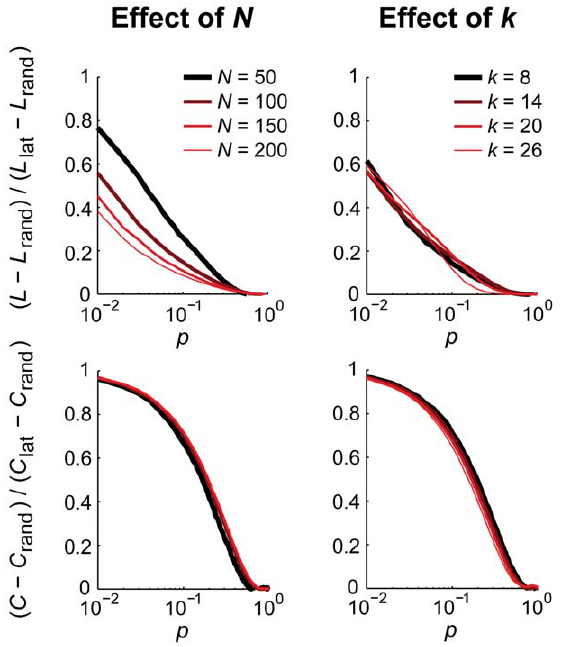
Figure 5. Normalization of graph measures by the range of possible values. Expressing path length ( L ) and clustering coefficient ( C ) as a ratio of the range of obtainable values (lattice - random) diminishes the sensitivity to changes in number of nodes N and average degree k . Only the path length remains largely sensitive to changes in N for a large range of rewiring probabilities p (the four curves do not coincide here). Shown are small-world networks with either a fixed k =10 or a fixed N =100.